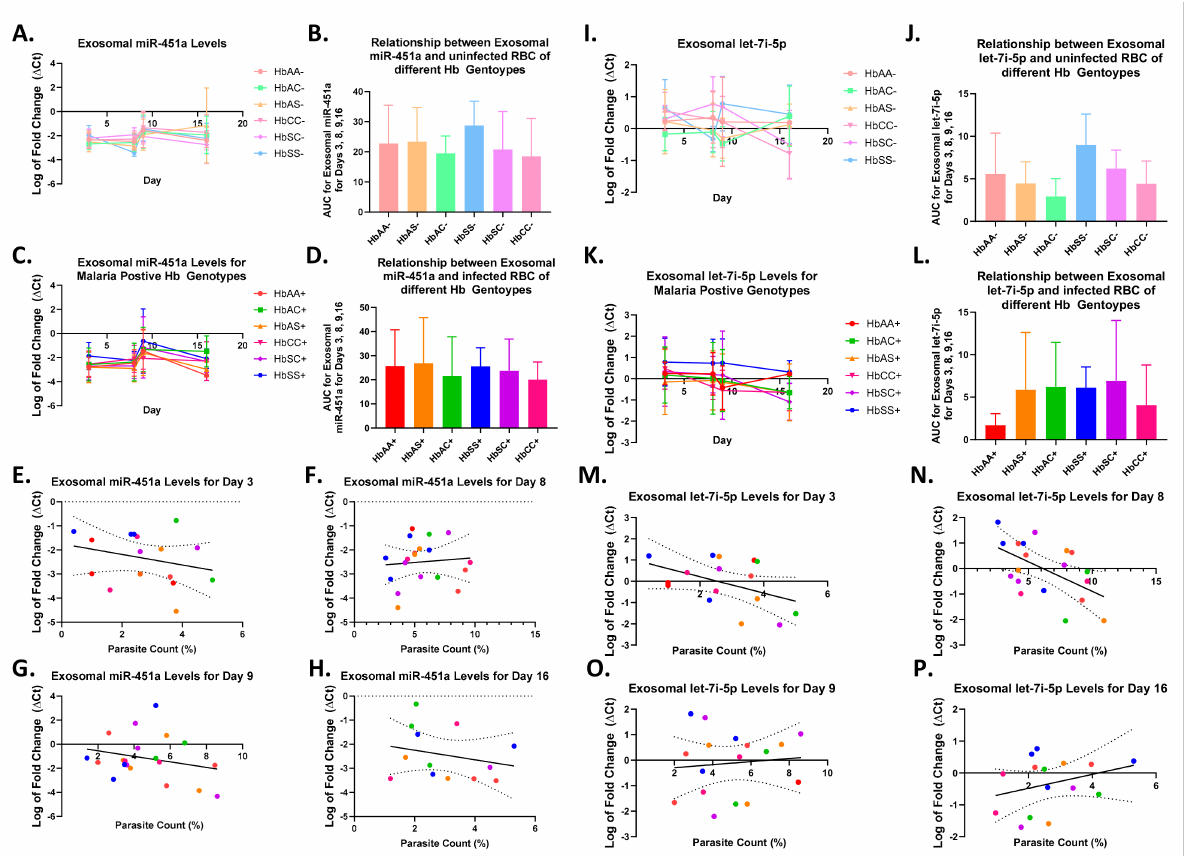
Figure 4. Exosomal miR-451a and let-7i-5p levels in Plasmodium -infected RBC and non-infected RBC of different sickle Hb genotypes. Area under the curve (AUC) was used to estimate exosomal miRNA levels over 16 days. A Pearson correlation was used for all correlations, and a linear regression was run. ( A ) shows the exosomal miR-451a levels of malaria-negative RBC with different hemoglobin (Hb) genotypes over 16 days. ( B ) presents the AUC for exosomal miR-451a levels over 16 days for each genotype without malaria. ( C ) displays the exosomal miR-451a levels of malaria-positive RBC with different sickle Hb genotypes over 16 days. ( D ) presents the AUC for exosomal miR-451a levels over 16 days for each sickle Hb genotype’s infected RBCs. ( E – H ) show the correlation between exosomal miR-451a levels and parasite count percentage on days 3, 8, 9, and 16, respectively. A significant positive correlation was observed on days 3 and 8 (R 2 = 0.29 and p = 0.02). ( F ) includes the equation of the regression line (Y = − 0.2316*X + 1.422). ( I , J ) display the exosomal let-7i-5p levels of malaria- negative RBC with different sickle Hb genotypes over 16 days and the AUC for exosomal let-7i-5p levels over 16 days for each genotype without malaria, respectively. ( K ) shows the exosomal let-7i-5p levels of malaria-positive RBC with different sickle Hb genotypes over 16 days. ( L ) presents the AUC for exosomal let-7i-5p levels over 16 days for each sickle Hb genotype’s infected RBCs. ( M – P ) show the correlation between exosomal let-7i-5p levels and parasite count percentage on days 3, 8, 9, and 16, respectively. The trend changes from a positive correlation on days 3 and 8 to a negative correlation on day 9, where let-7i-5p decreases with an increase in parasite count. ( O ) includes the equation of the regression line (Y = − 0.2302*X −